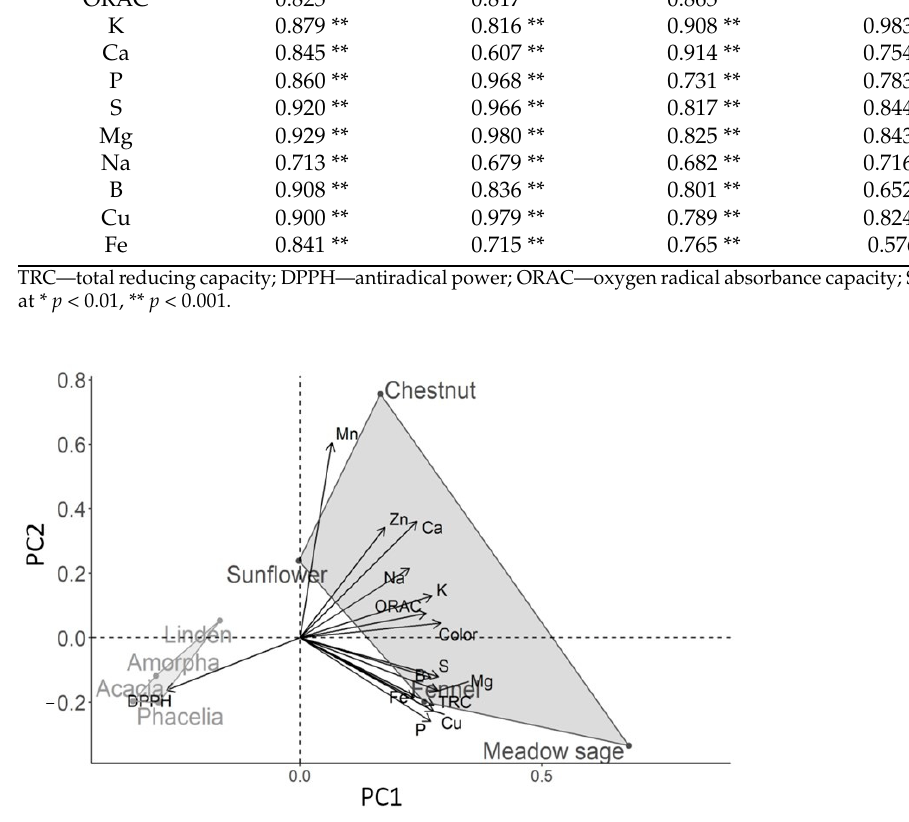
Figure 3. Scatter plot generated from a correlation matrix PCA indicating the direction of each variable and the position of each honey sample on the PC1–PC2 independent